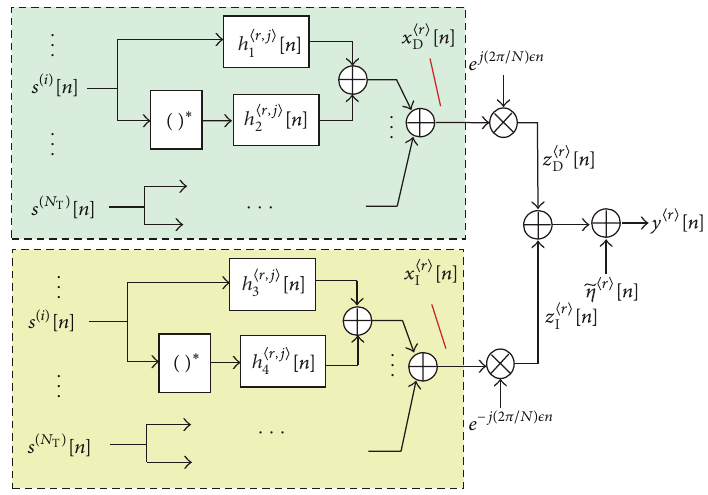
Figure 4: Simplified baseband model with CFO and frequency-selective I/Q imbalance.